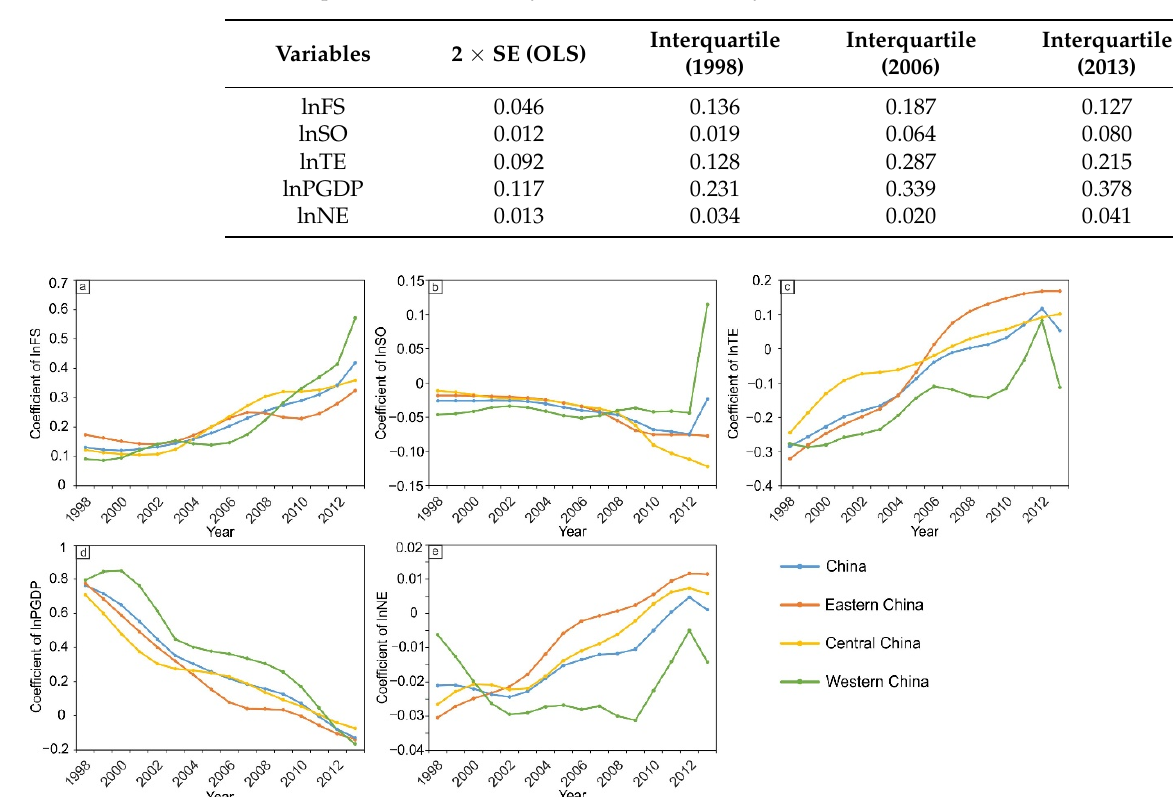
Figure 6. Coefficients estimated of FS ( a ), SO ( b ), TE ( c ), PGDP ( d ), and NE ( e ) in each region through